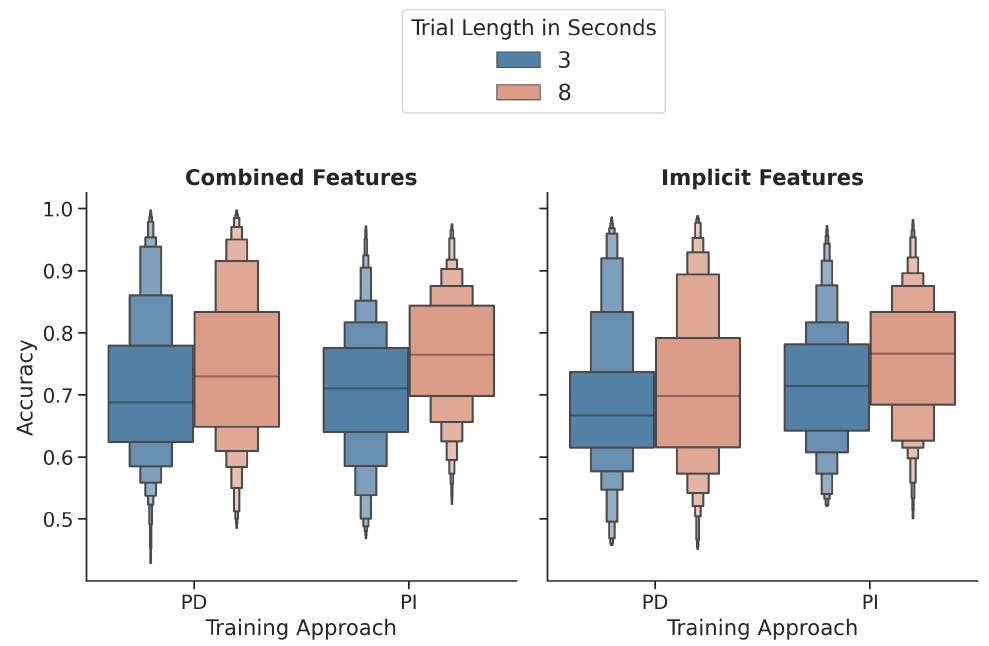
Figure 5. Comparison of the 3 and 8 s windows for person-dependent and independent classifiers using the combined and the implicit feature sets. PD = Person-dependent; PI =